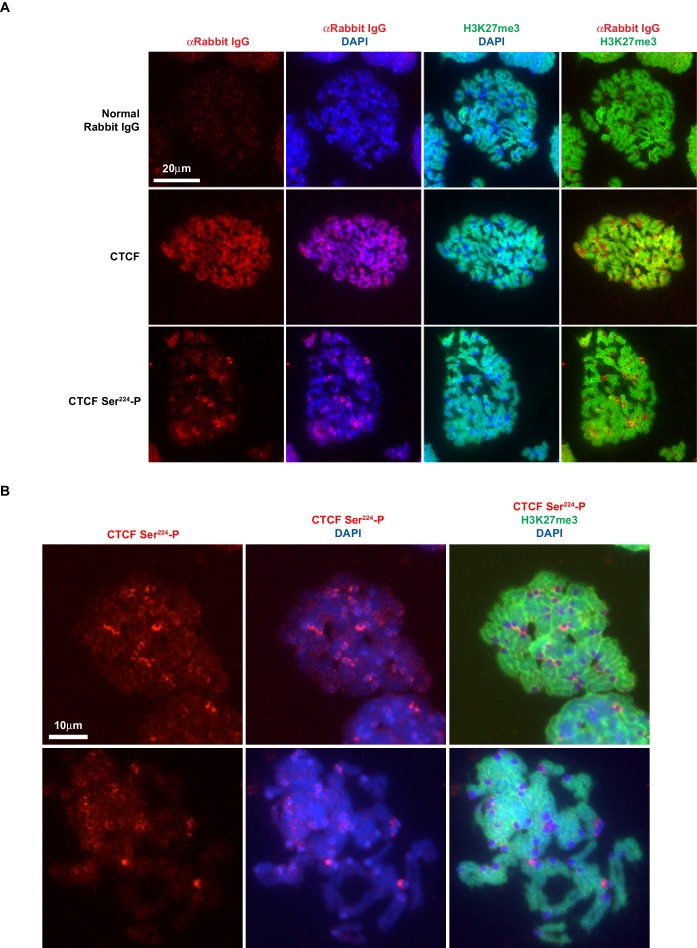
CTCF Ser224-P is enriched at pericentric regions of metaphase chromosomes.(A) Immunofluorescence performed on TST-1 mESC metaphase chromosomes using the indicated antibodies. DNA stained with DAPI. CTCF Ser224-P images are replicated from Figure 3G and are shown for comparison purposes. Bar, 20 μm. (B) Two additional examples of immunofluorescence on TST-1 mESC metaphase chromosomes using anti-CTCF Ser224-P and anti-H3K27me3 antibodies. DNA stained with DAPI. Bar, 10 μm.